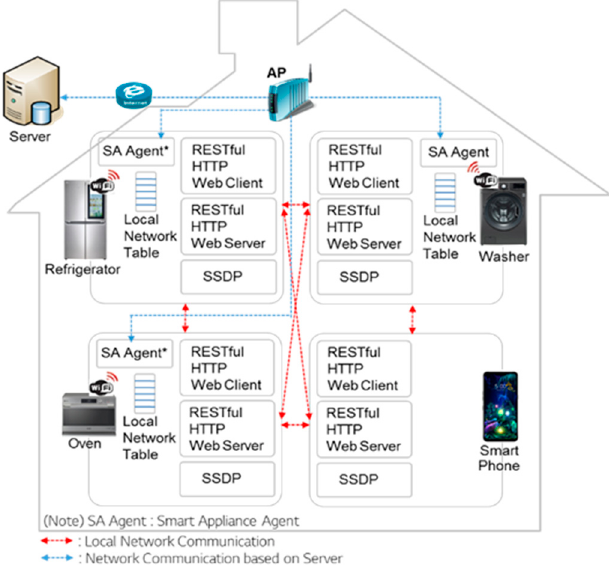
Figure 2. Local network devices on the hybrid appliance local network (HALN) architecture.